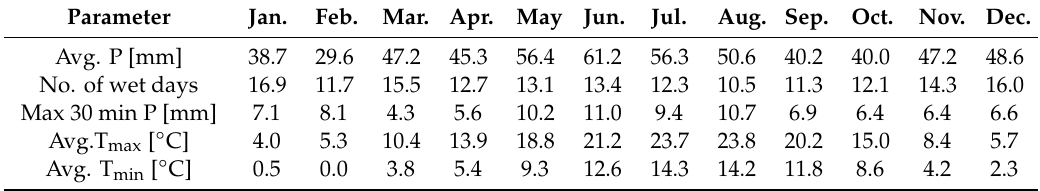
Table 1. Climate data used for Water Erosion Prediction Project (WEPP) modeling, excerpt from CLIGEN parameter file.